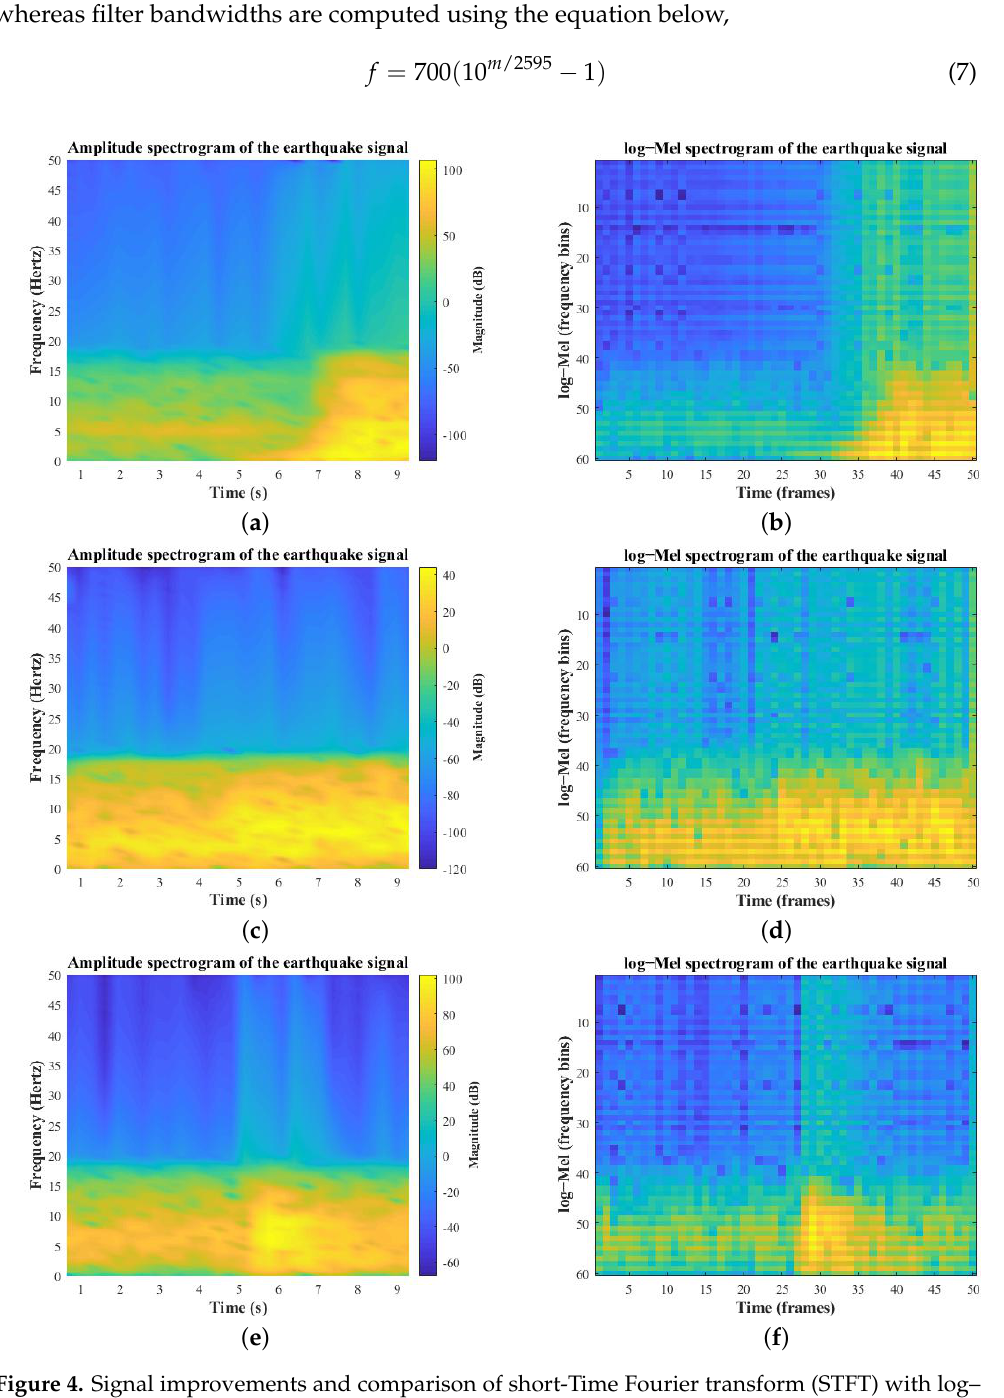
Figure 4. Signal improvements and comparison of short-Time Fourier transform (STFT) with log– Mel spectrograms of the earthquake signals. ( a ) STFT of earthquake magnitude > 4; ( b ) log–Mel spectrogram of earthquake magnitude > 4; ( c ) STFT of earthquake magnitude > 2; ( d ) log–Mel spectrogram of earthquake magnitude > 2; ( e ) STFT of earthquake magnitude > 3; ( f ) log–Mel spectrogram of earthquake magnitude >